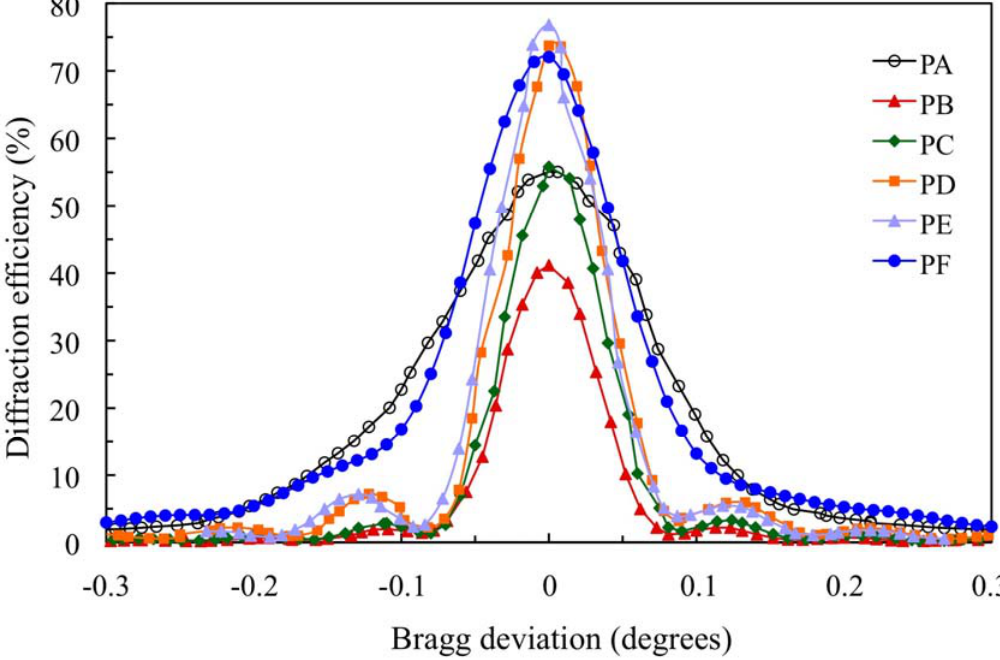
Figure 4. Angular scan for the holograms recorded in the 900 μ m photopolymer